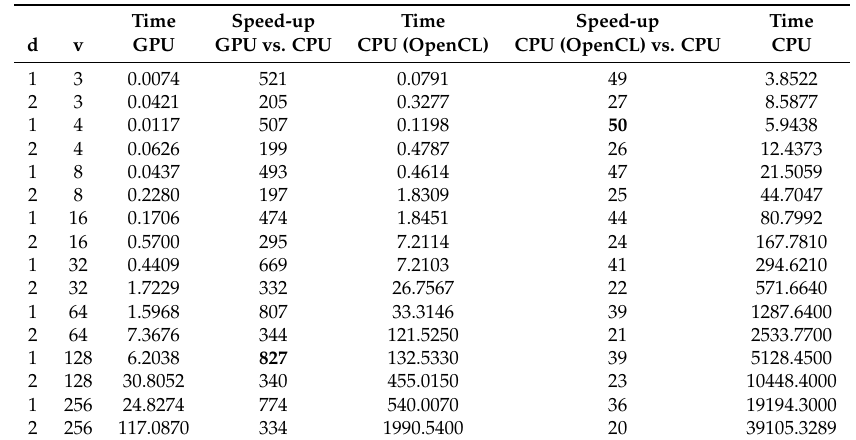
Table 4. Performance of the NLM algorithm applied to any band of the Desert image (size 6981 × 256) for different values of the similarity ( d , column 1) and search ( v , column 2) windows. Computational time of the portable OpenCL code run on GPU and CPU platforms is shown in columns 3 and 5, respectively. Moreover, column 7 reports the computational time of the sequential algorithm for the CPU. The speed-up of the portable parallel algorithm with respect to the sequential one run on the GPU and on the CPU is also shown in columns 4 and 6, respectively. Cases with the highest speed-up are highlighted in boldface.